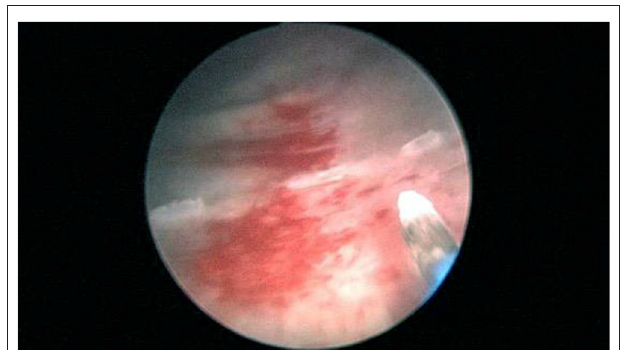
FIGURE 3 | Mark the pre-resection